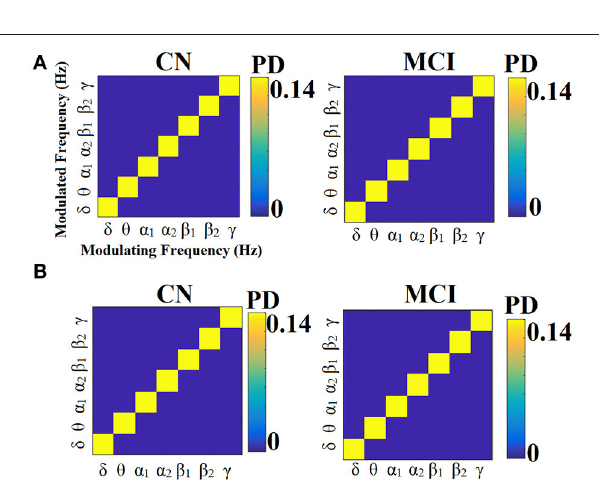
FIGURE 13 | Group-averaged comodulograms derived from ML-FCG CorrEnv . (A) PCA ROI representation. (B) Centroid ROI representation. PD, probability distribution.